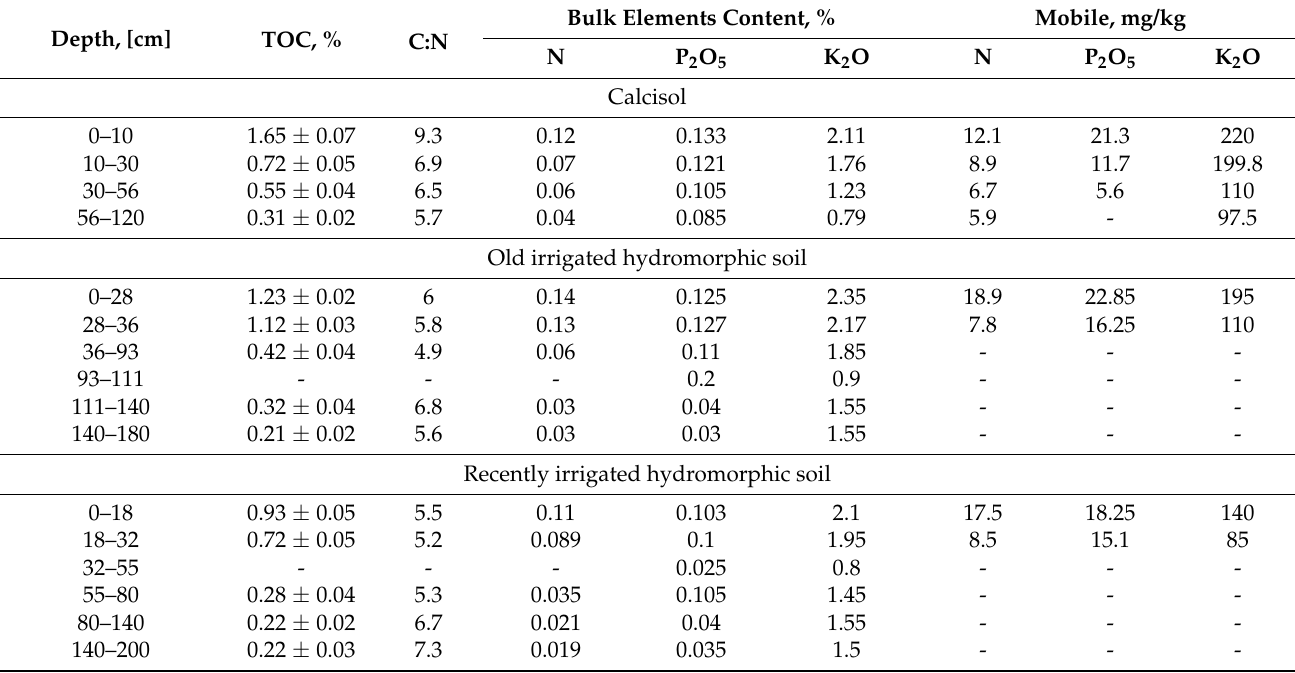
Table 3. Agrochemical characteristics of